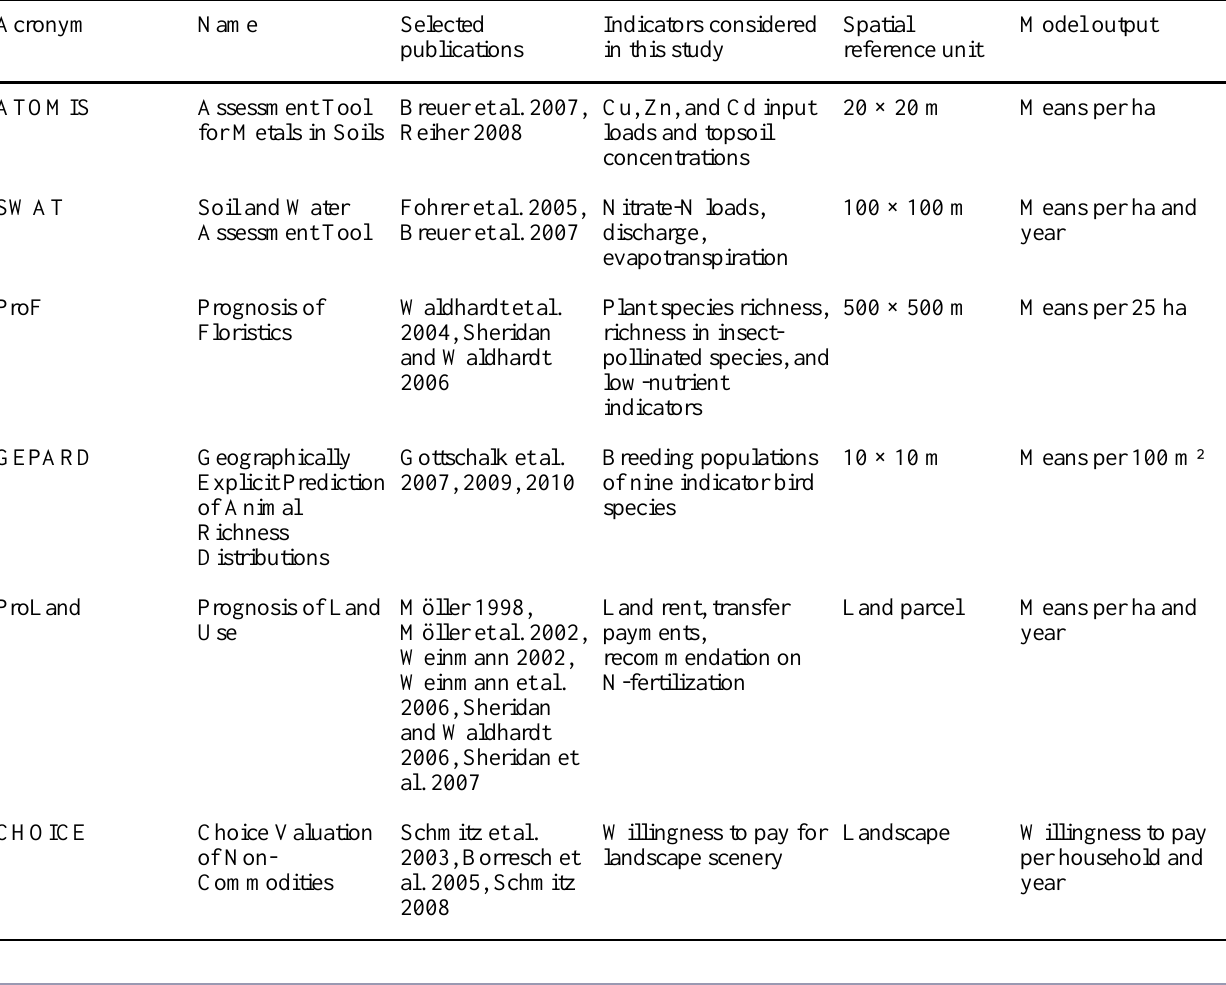
Table 1 . The model network ITE²M with its indicators, spatial reference units, and model output considered in this study. All models, with the exception of SWAT (Arnold et al. 1998), were developed in the research groups contributing to this